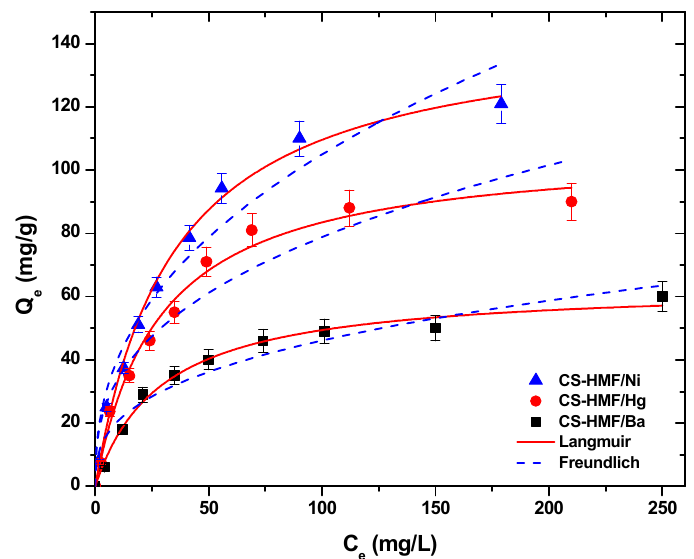
Figure 5. Equilibrium data for the uptake of Ni 2+ , Hg 2+ , and Ba 2+ from aqueous solutions (single component). Fitting to the equations of Langmuir and Freundlich. Testing conditions: T = 25 °C, C 0 = 10.0–300.0 (mg/L), N = 160 rpm, V = 20.0 mL, t = 200 min, m = 0.02 g, pH = 6.